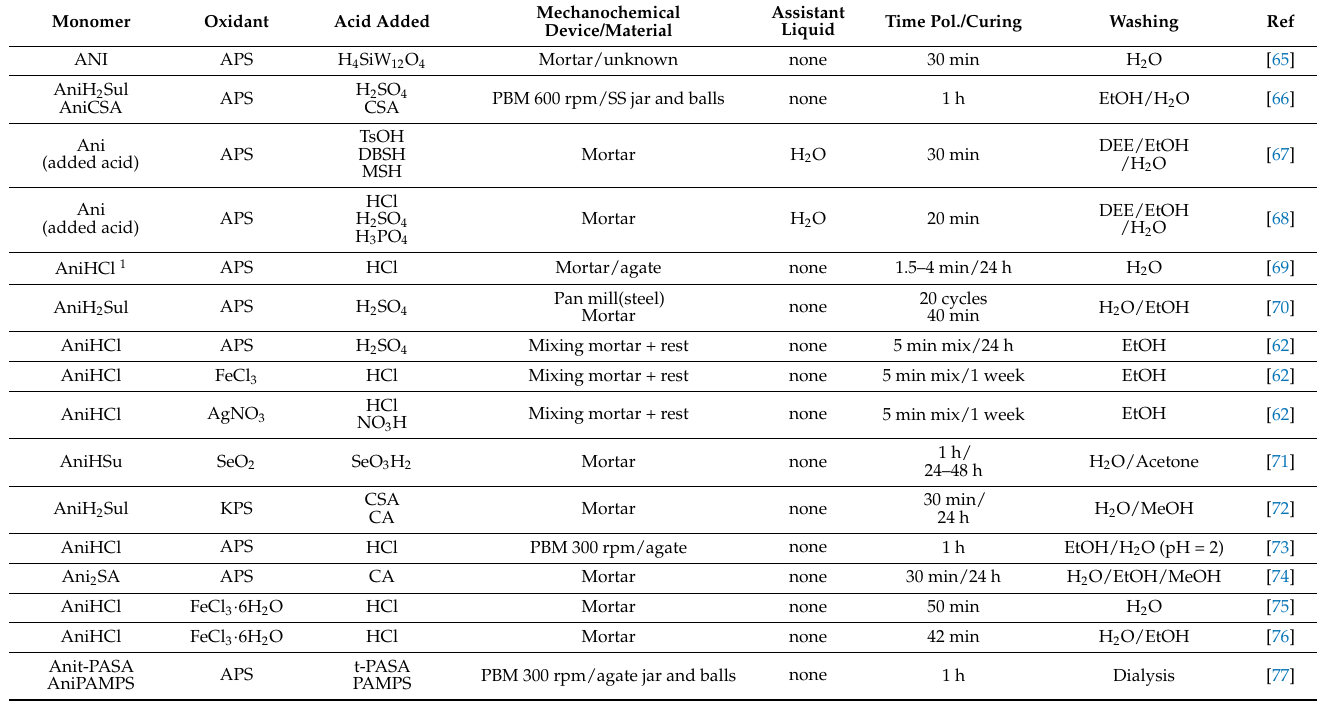
Table 1. Summary of reaction conditions for MCP of